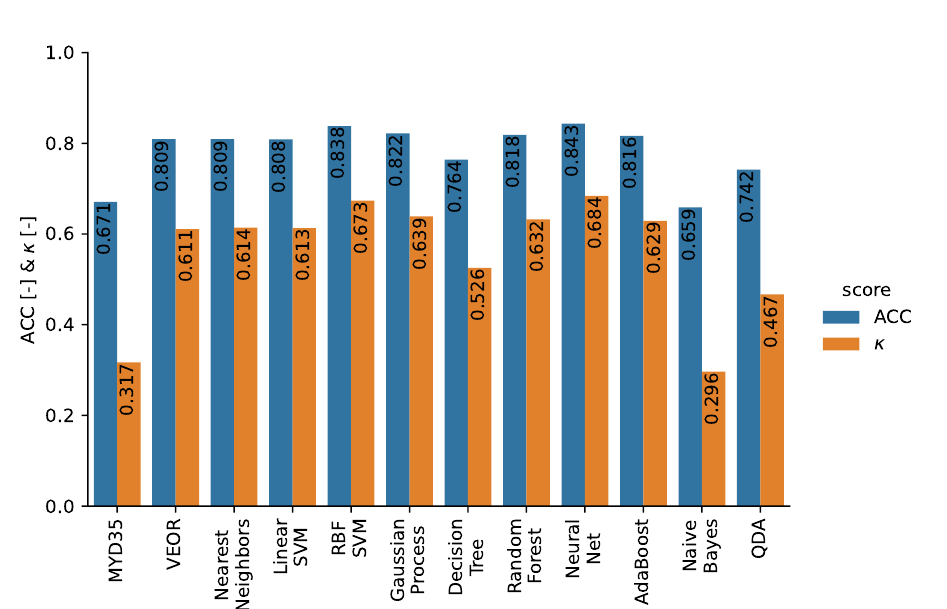
Figure 8. Comparison of classifier performance for cloud discrimination over ice/snow surfaces using MODIS spectral measurements collocated with the CALIOP/CPR reference cloud mask. MYD35 denotes AQUA MODIS collection 6 cloud mask